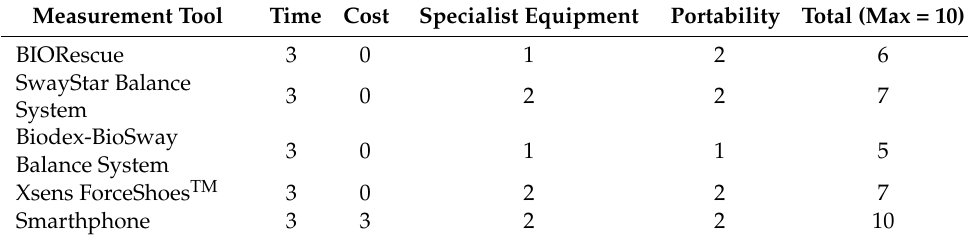
Table 4. Oxford Scale.